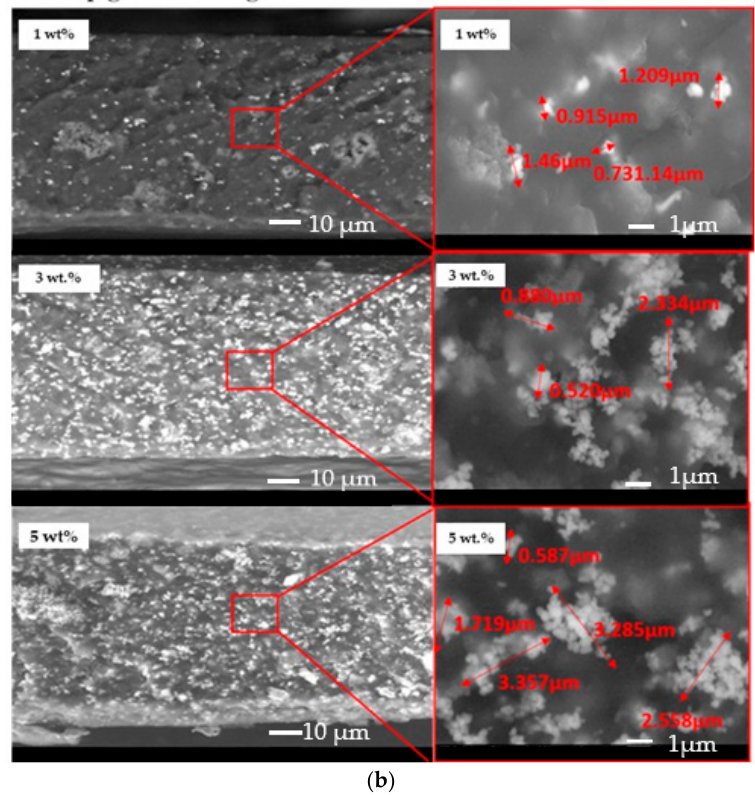
Figure 4. Cross-sections of the investigated samples: black pigmented coatings ( a ) and yellow- pigmented coatings ( b ).